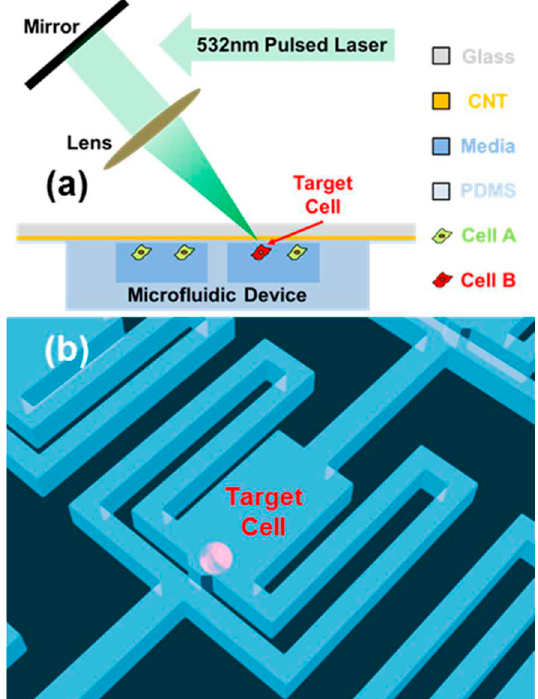
Figure 17. Schematic diagram of a single-cell detachment setup. ( a ) Cells were cultured in the microfluidic chamber coated with the CNT − PDMS composite. A short pulse laser is used to detach the target cell; ( b ) Microfluidic chamber and channel for cell capture and retrieval. Reprinted with permission from [105]. Copyright (2017) American Chemical Society.